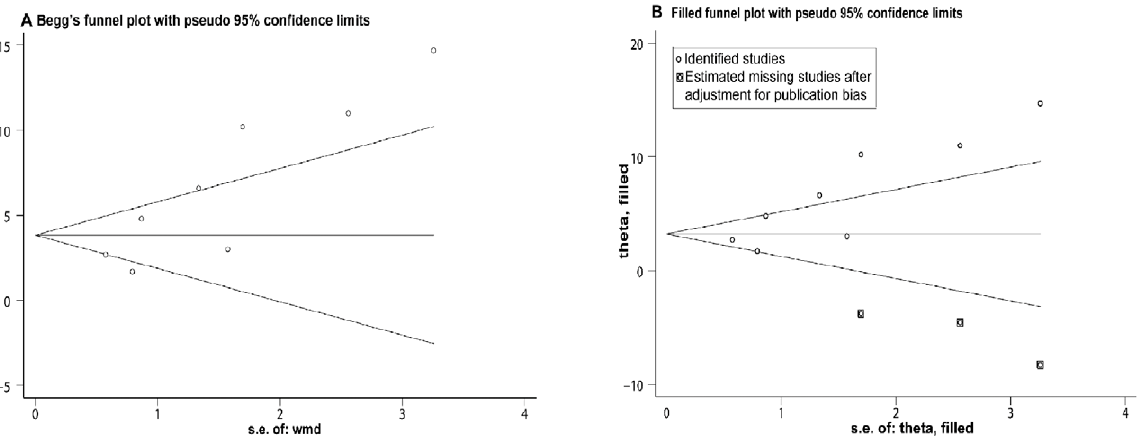
Figure 3. Funnel plot of all studies on the effects of PTH and bisphosphonates on spine BMD. A: Begg’s funnel plot with pseudo 95% confidence limits. B: Filled funnel plot with pseudo 95% confidence limits. WMD, weighted mean difference; S.E., standard error.